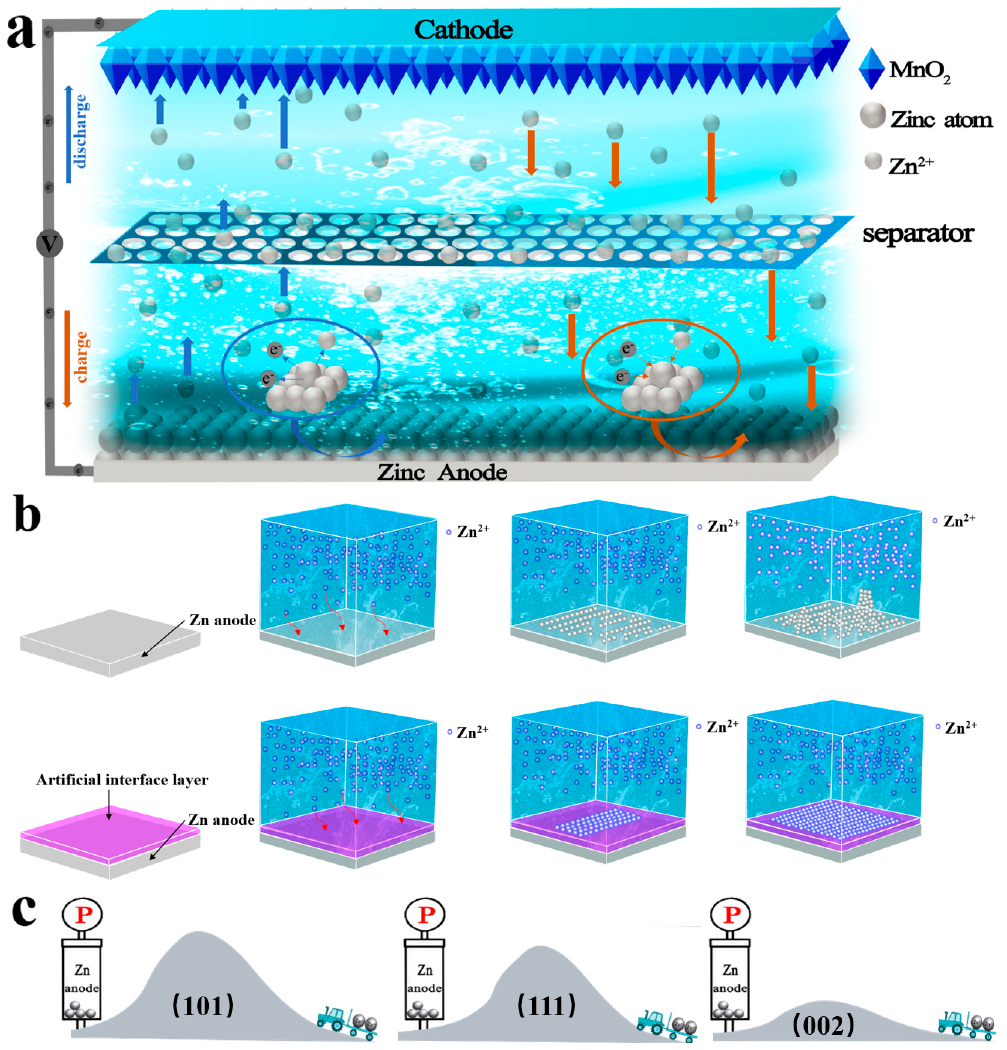
Figure 3. ( a ) Schematic diagram of charge and discharge processes of an aqueous zinc-ion battery. ( b ) Zinc dendrite growth process and inhibitory growth process after modification. ( c ) Diagram of the di ffi culty of zinc ion deposition in three crystal planes: (101), (111), and (002).